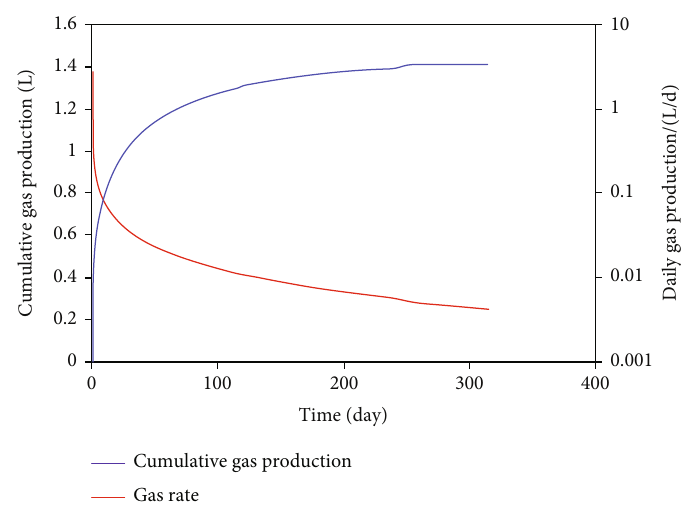
Figure 3: Gas production and gas production rate versus production time.